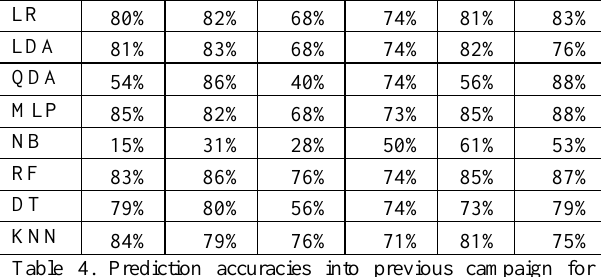
Table 4. Prediction accuracies into previous campaign for Vinhão Best prediction accuracies in Vinhão from October to August were achieved by RF with 86% using the second dataset and by MLP with 85% using the first dataset. Very poor performance was achieved by NB. Best results from October to July were achieved with RF and MLP; the latter had performances similar to LR and LDA. In predictions from August to July best scores were clearly achieved by RF and MLP. In Table 5. are presented predictions results to previous campaigns for Loureiro